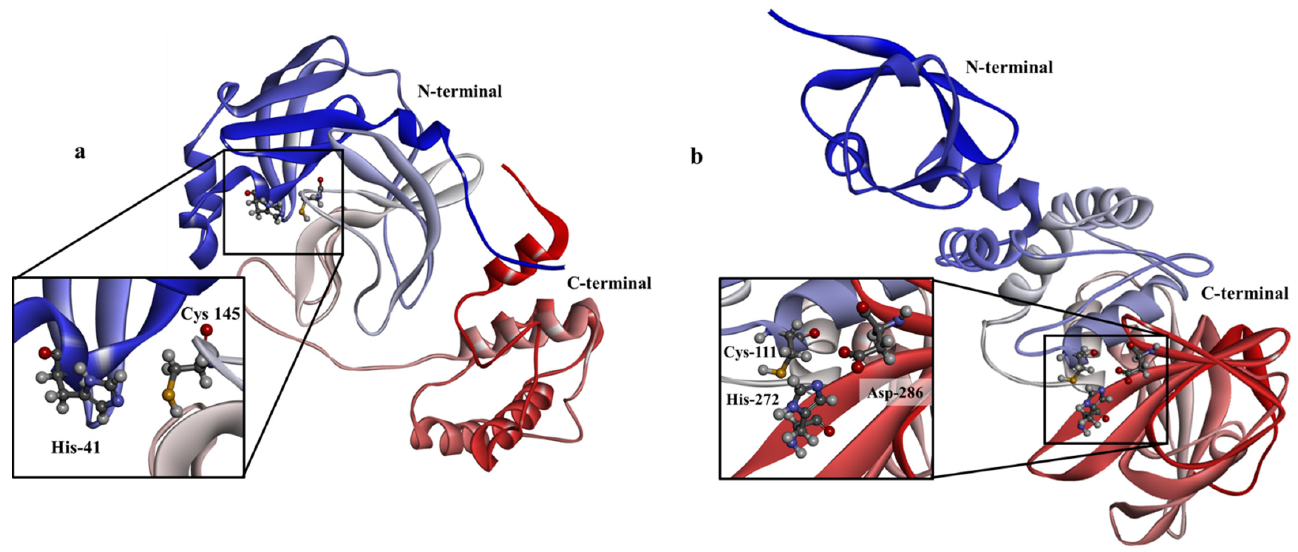
Figure 1. Three-dimensional structure of SARS-CoV-2 ( a ) main protease (3CLpro, PDB ID: 6XA4) [18] and ( b ) papain-like protease (PLpro, PDB ID: 6WX4) [19] showing the active site and essential domain within the enzyme (rendered using BIOVIA Discovery Studio [32]).